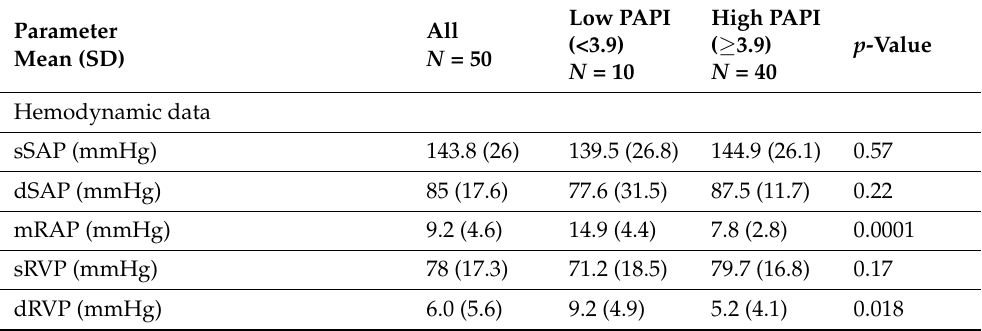
Table 2. Comparison of hemodynamic and echocardiographic data between low- and high- PAPI